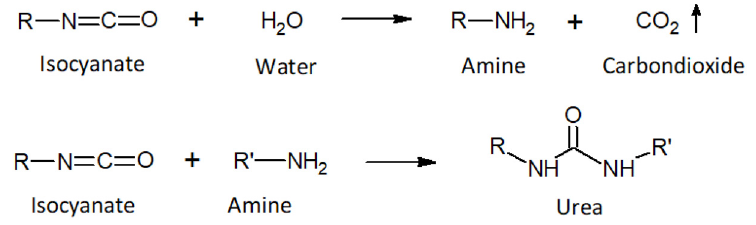
Scheme 1. Reaction of uncontrolled foaming occurring during the manufacturing of materials.